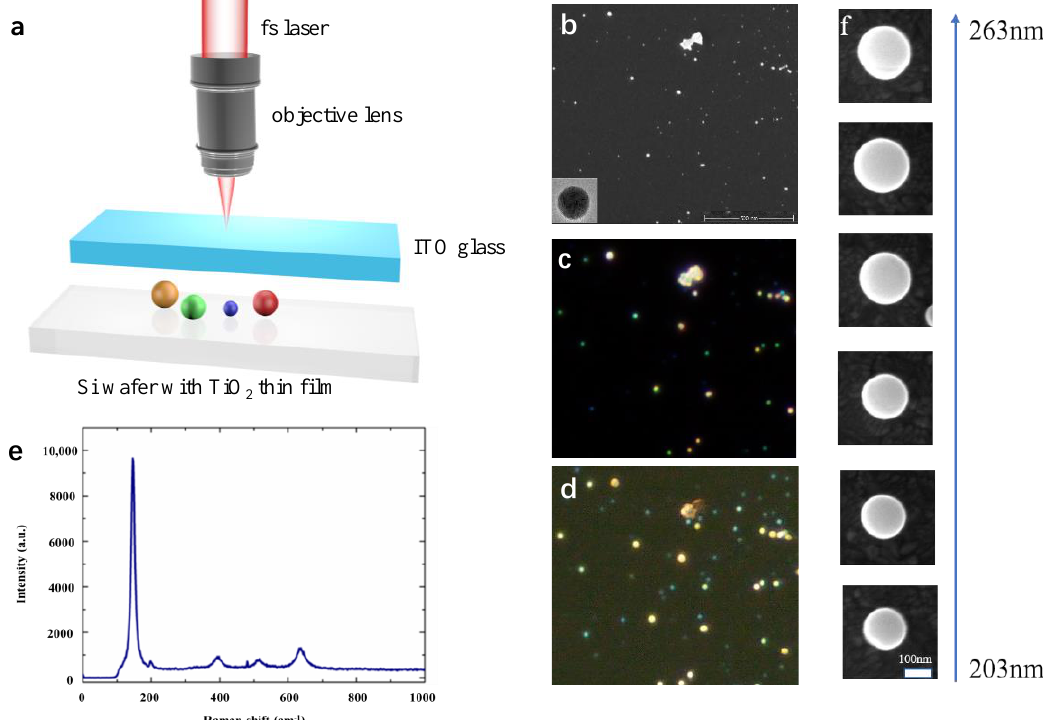
Figure 3. ( a ) Schematic of the laser-splashed process for nanoparticle fabrication. ( b ) SEM image of fabricated nanoparticles with the inset showing the TEM image of one representative nanoparticle. ( c , d ) Reflective and transmissive dark-field microscopy images of the areas corresponding to the SEM image area. ( e ) The Raman spectrum of one representative TiO 2 nanoparticle. ( f ) SEM images of selected nanoparticles with various diameters from 203 nm to 263 nm.